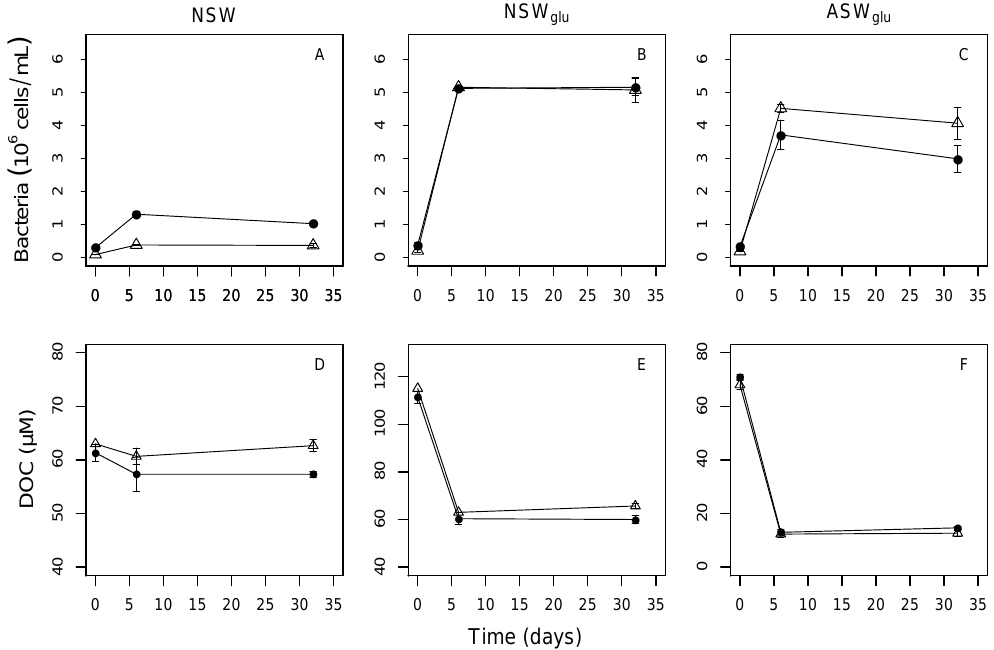
Figure 2. Bacterial abundance and DOC concentration. The data points and error bars represent means and standard deviations calculated from triplicate measurements. • represents Atlantic treatments and 1 represents Arctic treatments. Note the different scales of the